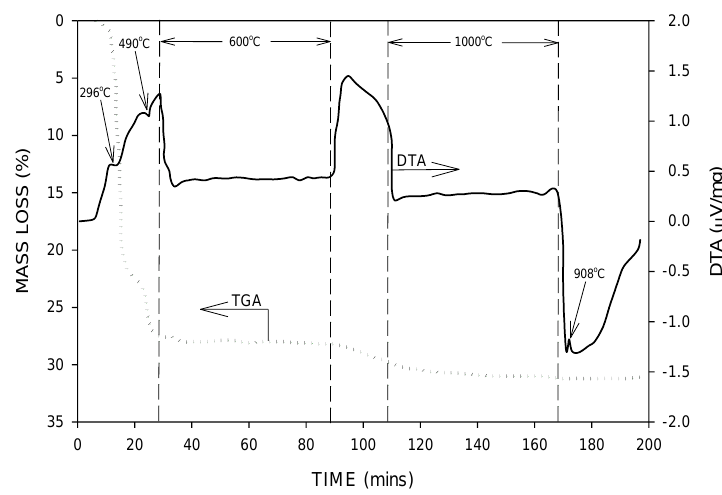
Figure 9. TGA/DTA results for reduction at 600 ◦ C and thermal growth at 1000 ◦ C for a mixture of Figure 9: TGA/DTA results for reduction at 600°C and thermal growth at 1000°C for a mixture limonite, coal and sulphur with a mass ratio of of limonite, coal and sulphur with a mass ratio of 2:1:1.